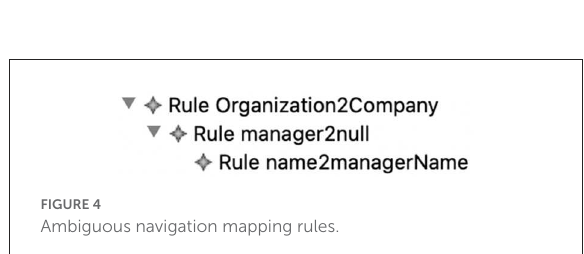
FIGURE4 Ambiguous navigation mapping